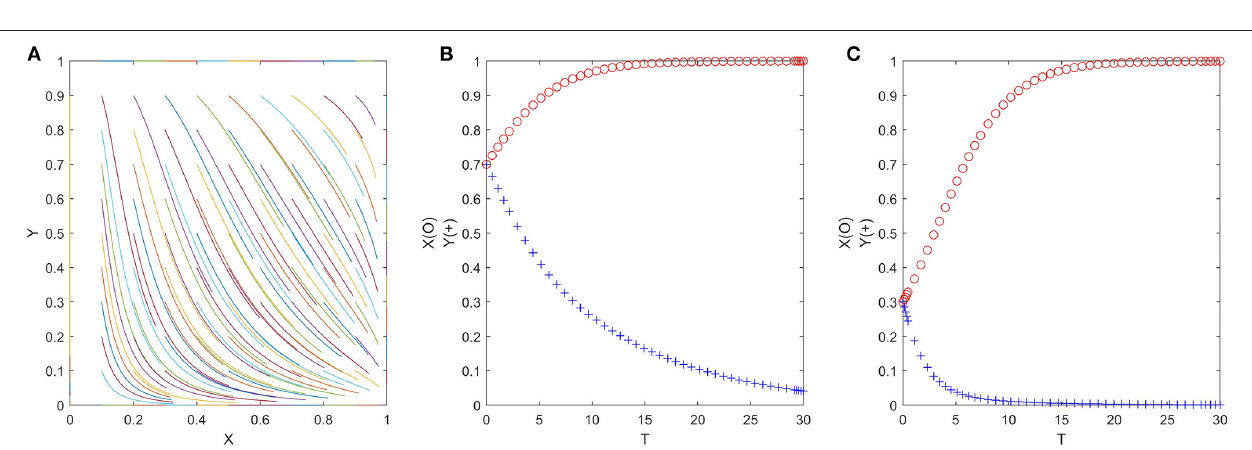
Frontiers in Psychology |